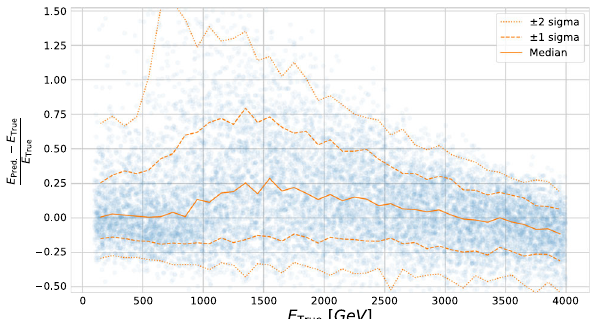
Fig. 9 Fractionalerrorofpredictionsasafunctionoftrueenergy,along with quantile trends. The ideal response is for all points to lie on a straight line along y = 0. The one and two sigma lines indicate the 50 ± 34 . 1% and 50 ± 47 . 7% percentiles, respectively